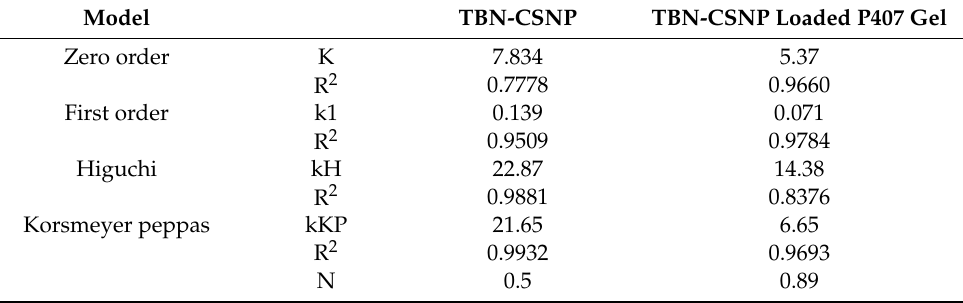
Table 3. Kinetic models for in vitro drug